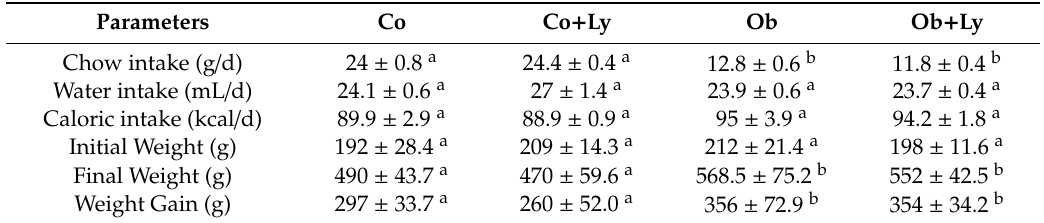
Table 1. Intake and weight characteristics.